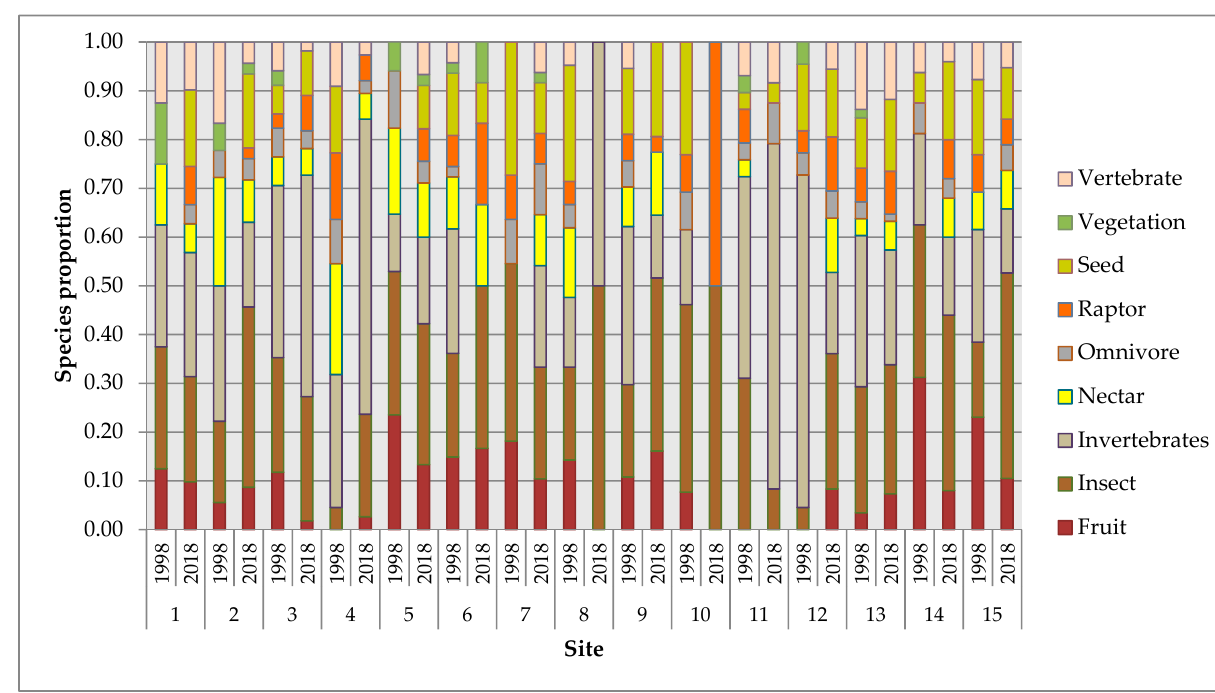
Figure 4. Proportion of species by primary food source at sites where greenspace has decreased.